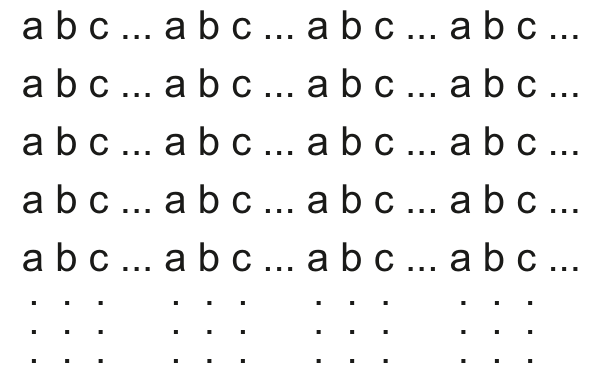
FIGURE 4 | Schematic representation of one hypercolumn in the receptor array in the cortex. Each letter represents a neural symbol that responds to a particular small pattern in the sensory data. The ellipsis, “...,” in each row and each column represents other neural symbols that would be shown in a more comprehensive representation of the given hypercolumn. Each vertical sequence of letters, all of one kind such as “ a ” or “ b ,” represents a simple column in the